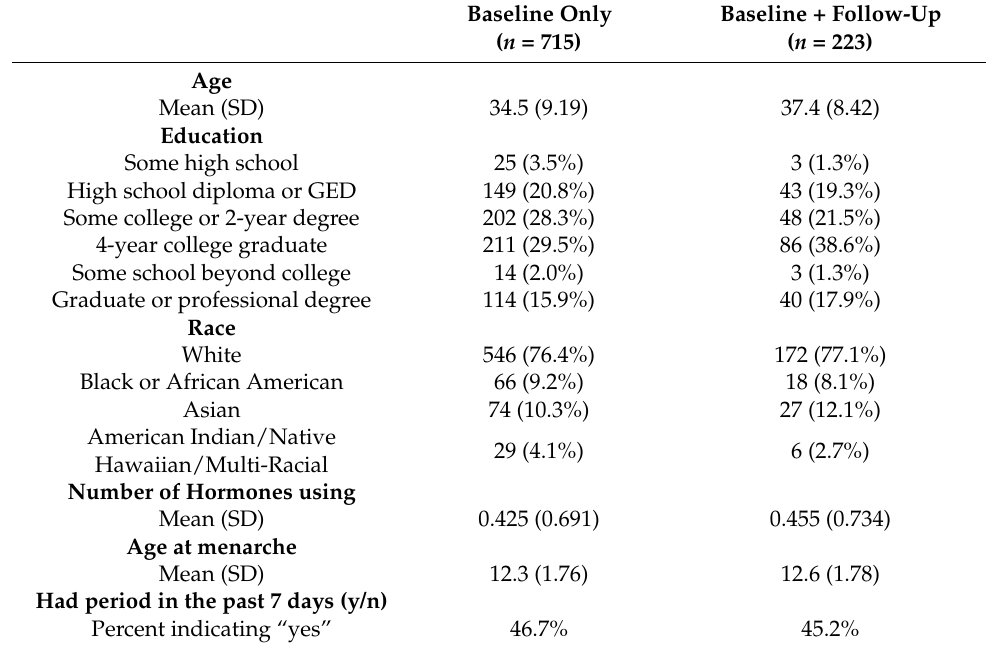
Table 1. Descriptive statistics of demographic and clinical variables at baseline for the two groups of subjects (Baseline only vs. Baseline + follow-up).